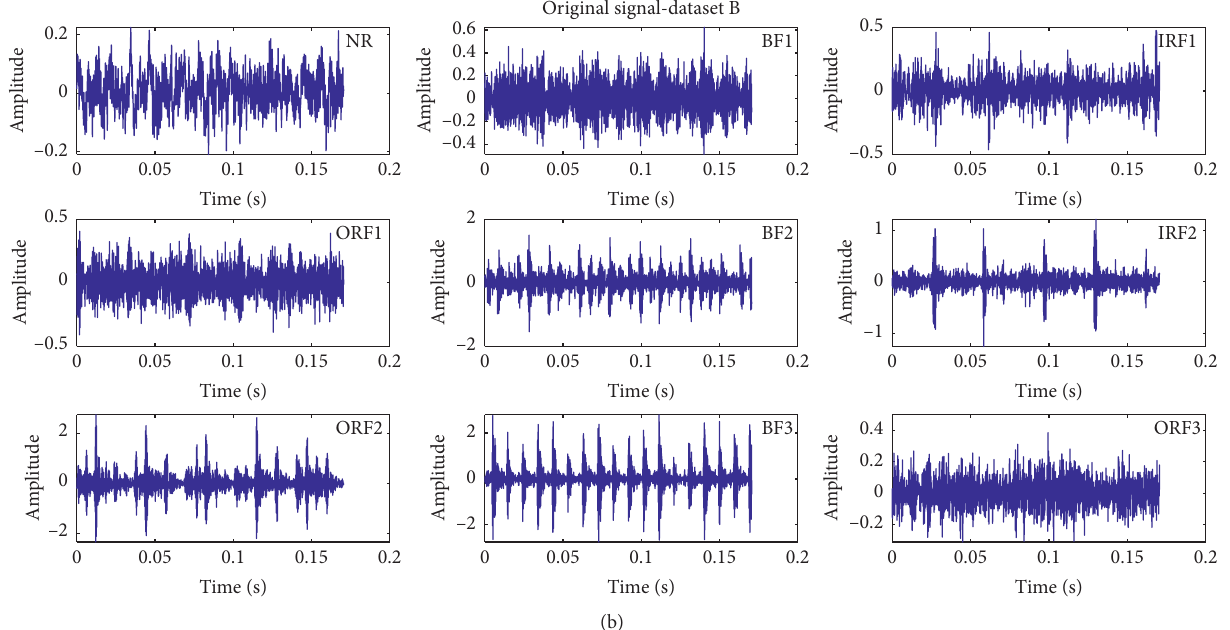
Figure 5: The original signal under various working conditions.